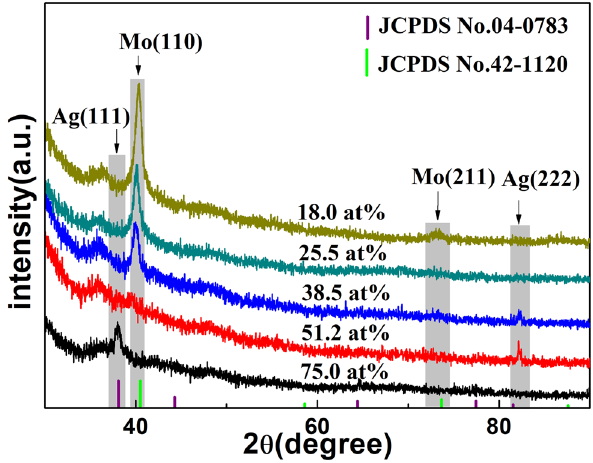
Figure 3: XRD patterns of the Ag nanoparticles/Mo – Ag alloy fi lms with di ff erent Ag